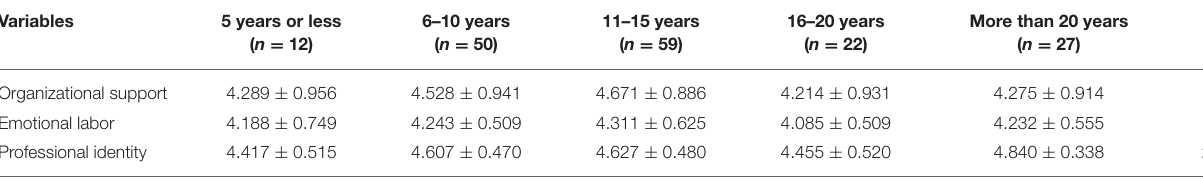
TABLE 3 | Results of the one-way analysis of variance test based on working years. Variables